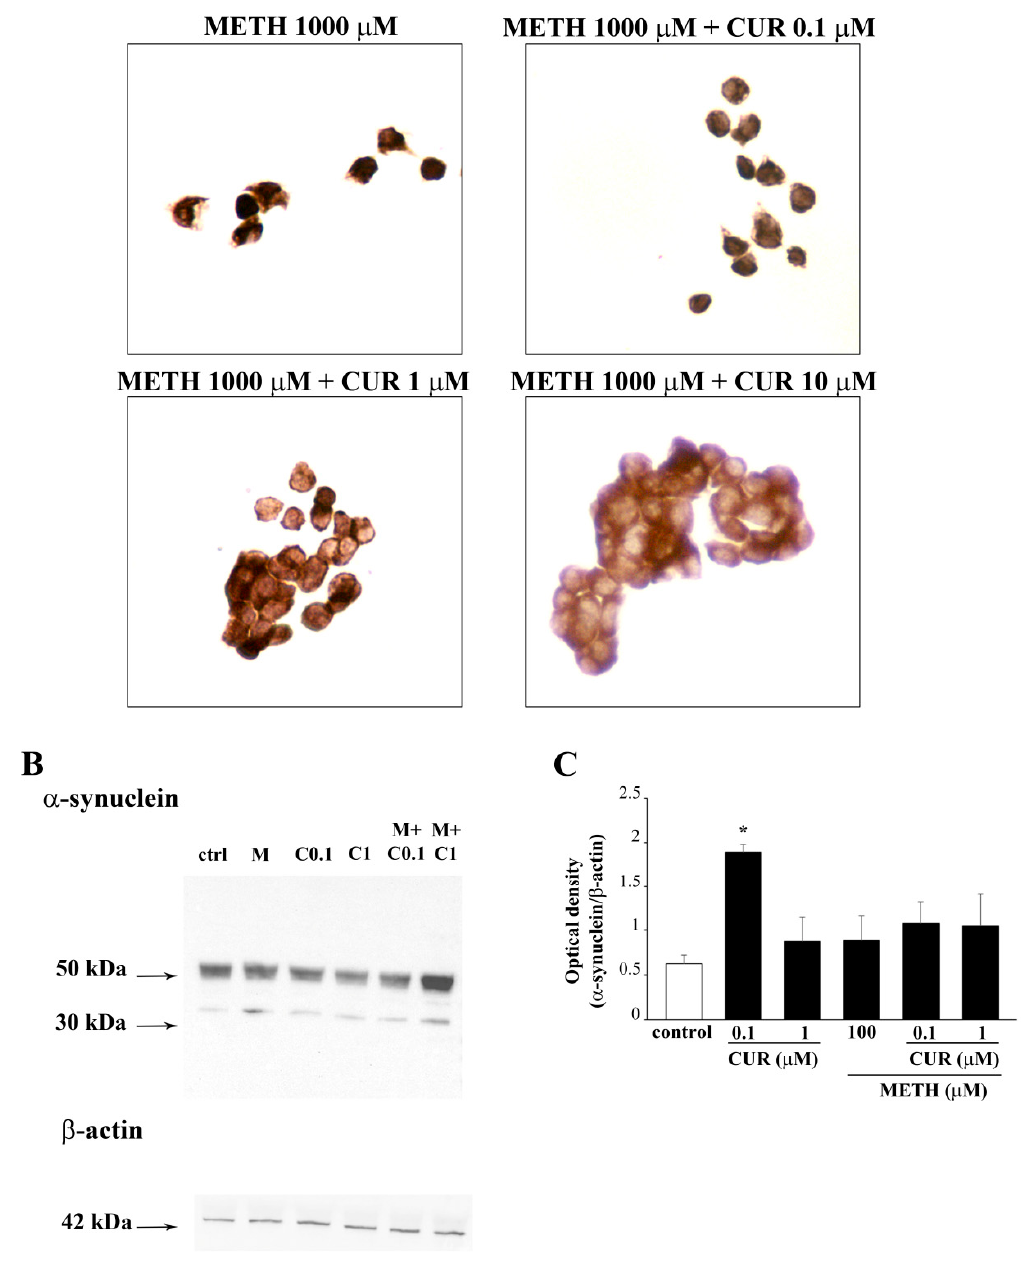
Figure 14. CUR mitigates the expression of α -synuclein in control and METH-treated cells. ( A ) Representative im- munostaining for α -synuclein. ( B ) Representative immunoblotting for α -synuclein and β -actin in control and PC12 treated cells and the related optical densities ( C ). (Ctrl = control; M = METH 100 μ M; C0.1 = CUR 0.1 μ M; C1 = CUR 1 μ M; M + C0.1 = METH 100 μ M + CUR 0.1 μ M; M + C1 = METH 100 μ M + CUR 1 μ M); * p < 0.05 compared with control. Scale bar = 16.1 μ M.